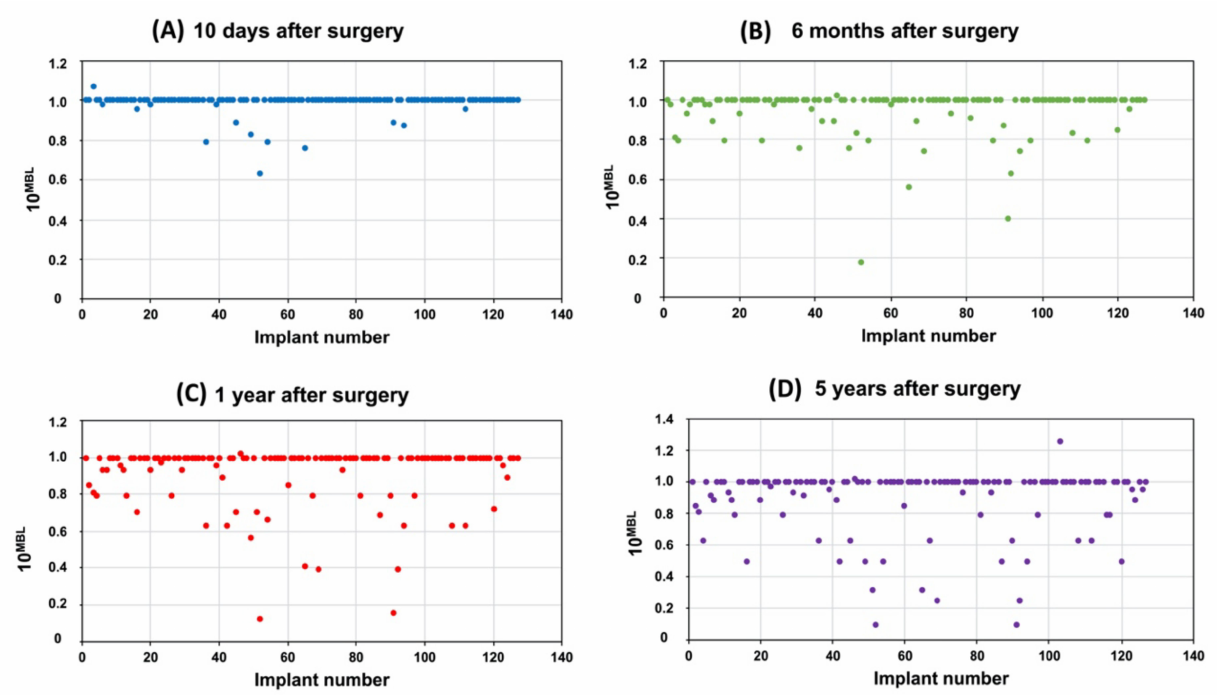
Figure 3. Marginal bone loss (MBL) values calculated around inserted implants at 10 days ( A ), 6 months ( B ), 1 year ( C ), 5 years ( D ) after surgery (MBL values were submitted to a base 10 exponential data transformation, to deal with the numerous zero values).